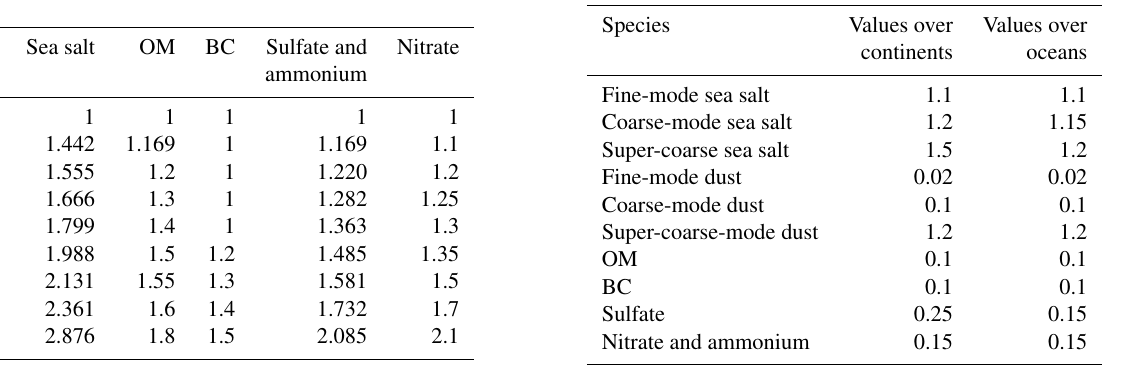
Table 7. Hygroscopic growth factor depending on ambient relative humidity.